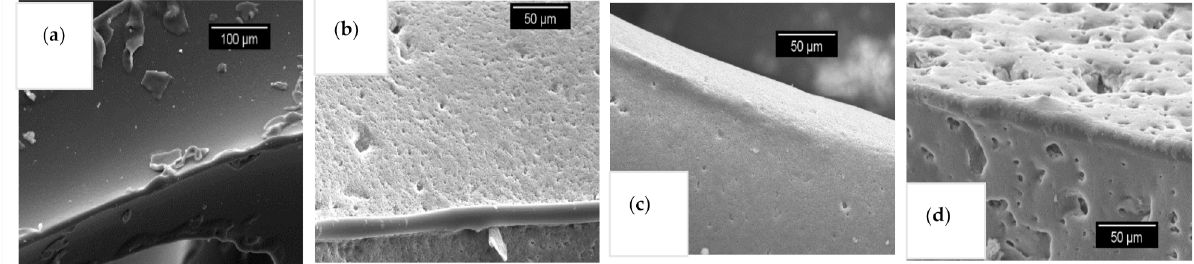
Figure 9. SEM micrographs of ( a ) original Polyurethane (PU) template, ( b – d ) coated PU templates with ceramic dispersions with 30 vol% solid load and different thickeners ( b ) Starch, ( c ) Methyl cellulose, ( d ) Wallpaper paste, dried at room temperature (before sintering—PU-template is still